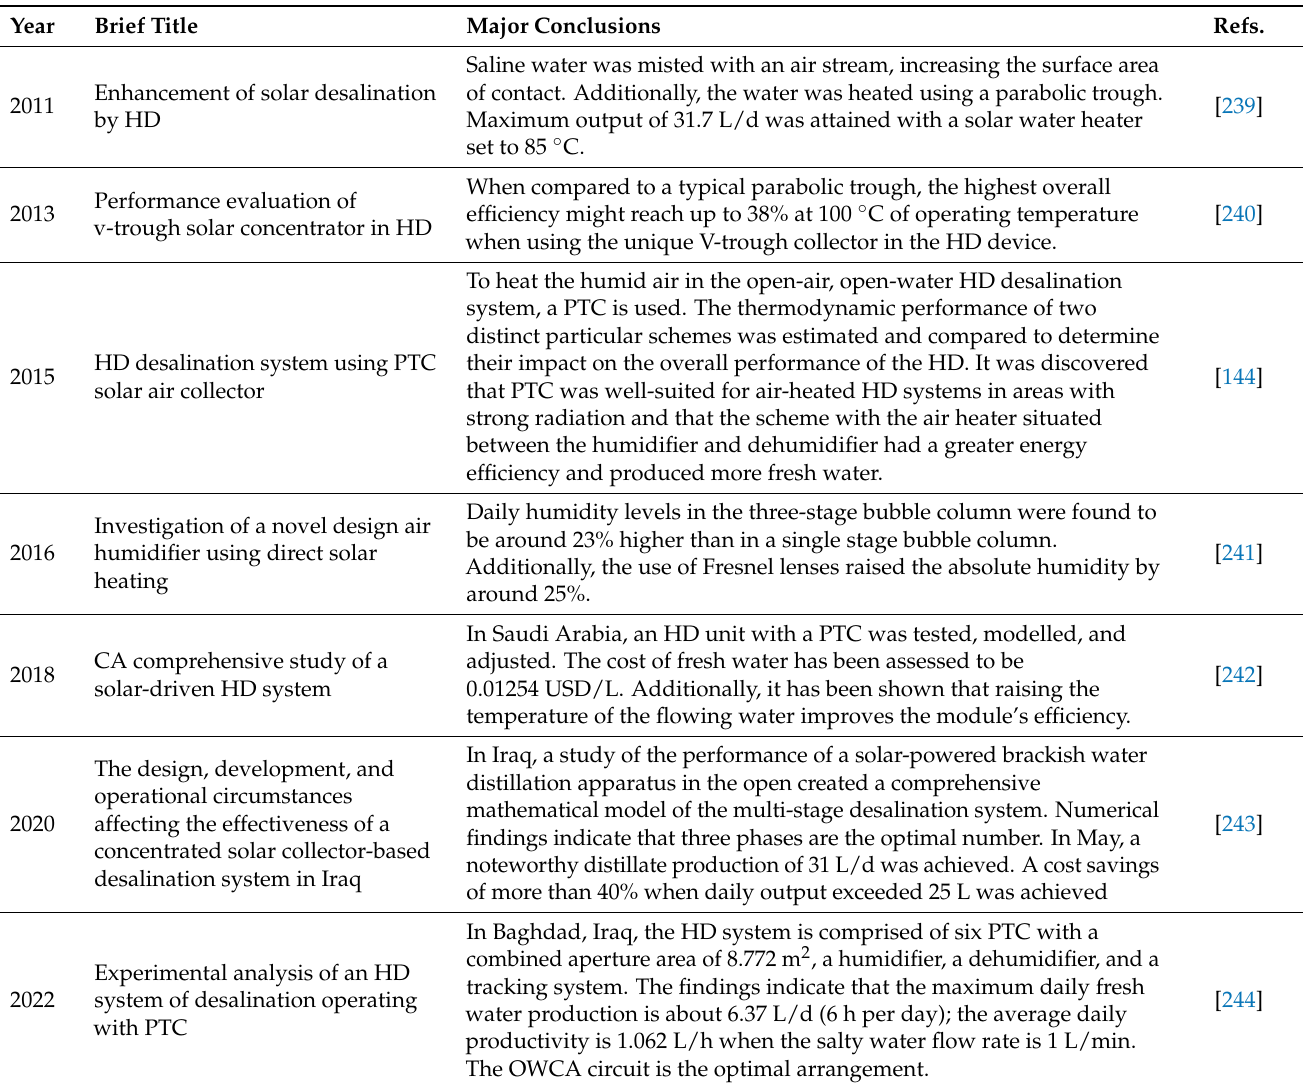
Table 7. A concise assessment of the experimental literature on the concentrating solar collector- HD